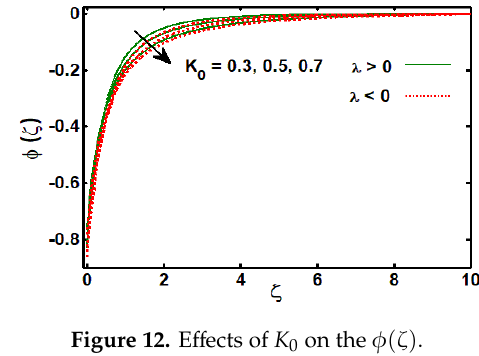
Figure 12. Effects of 𝐾 0 on the 𝜙(𝜁) .